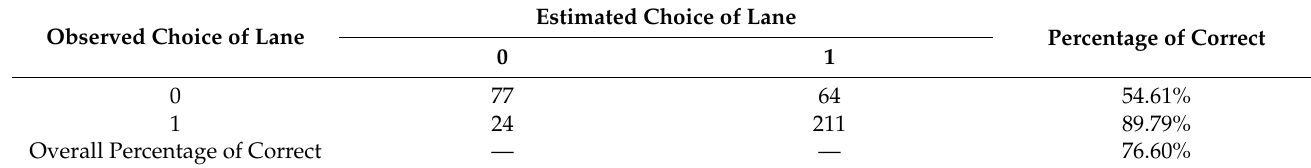
Table 4. Classification table for analysis of model